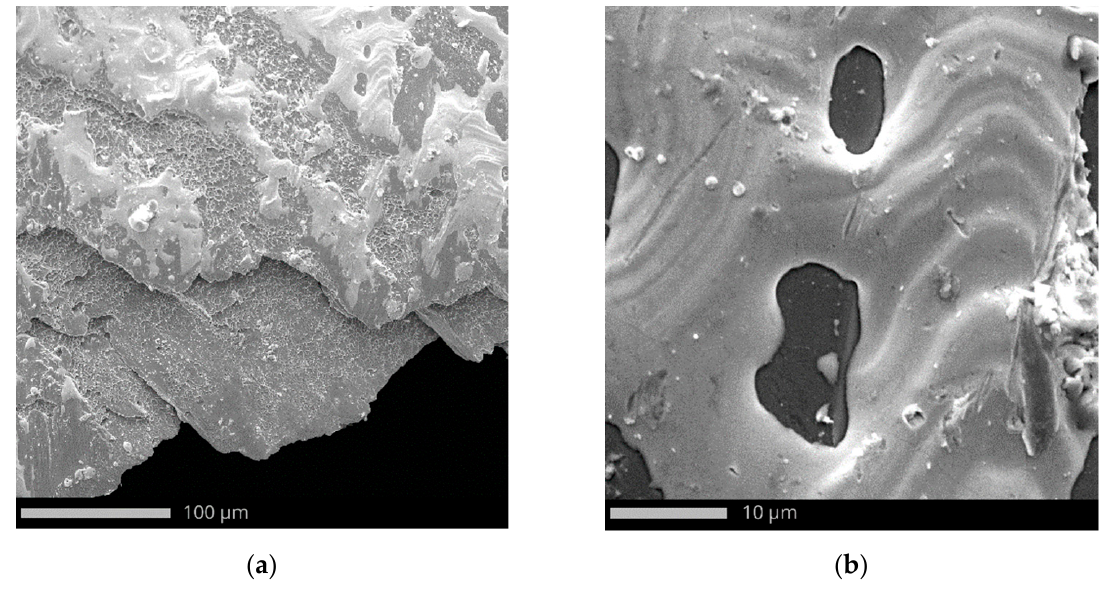
Figure 12. Edge of inlet with bright areas covered with lead from projectile material: ( a ) magn. ×810 and ( b ) magn. ×6300.